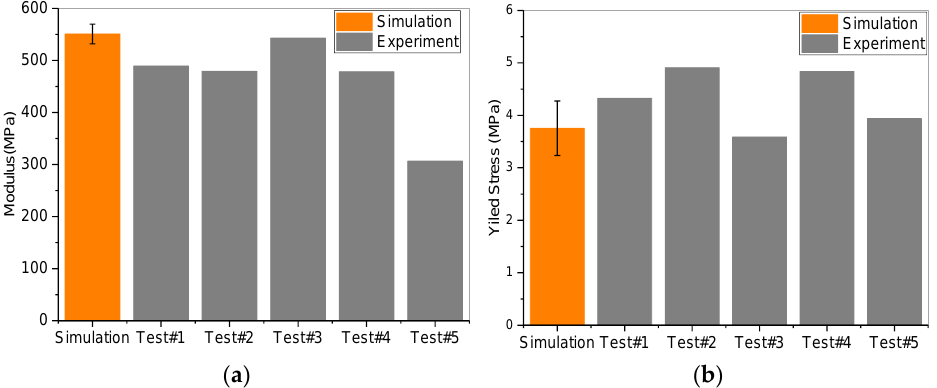
Figure 11. The Young’s modulus and yield stress from simulation and test: ( a ) Modulus; ( b ) Yield stress.